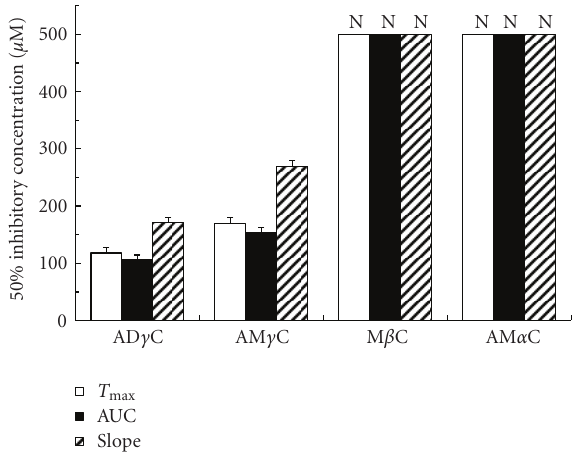
Figure 4: Concentrations of carbolines to produce 50% inhibition of the first phase platelet aggregation responses ( T max , AUC, and slope) to epinephrine. N: Not inhibited by 50% at the indicated concentrations. Data are presented as mean ± SE ( n =